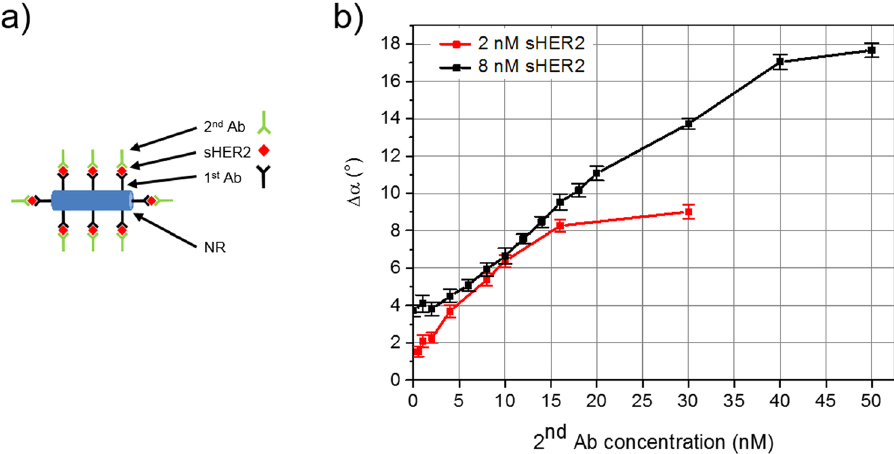
Figure 1. Signal dependence on secondary antibody concentration. ( a ) Sketch of the nanorod (NR) based sandwich-type immunoassay employing primary (1 st ) and secondary (2 nd ) antibodies (Ab); ( b ) Phase lag difference Δα in measurement buffer solution for two fixed concentrations of sHER2 analyte molecules (2 and 8 nM) in dependence of the added concentration of 2 nd